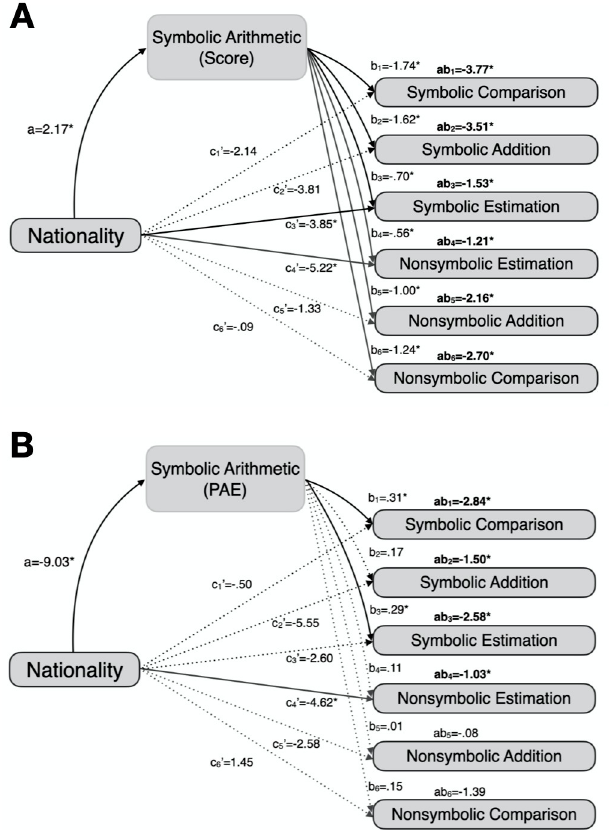
Fig 6. Alternative mediations. Solid and dotted lines represent significant and non-significant relations between variables respectively. Symbolic arithmetic scores are the significant mediator of the effect of nation on all six numerical magnitude tasks (A), whereas symbolic arithmetic PAEs significantly mediate nationality effects on symbolic-numeric and spatial-numeric tasks (B).